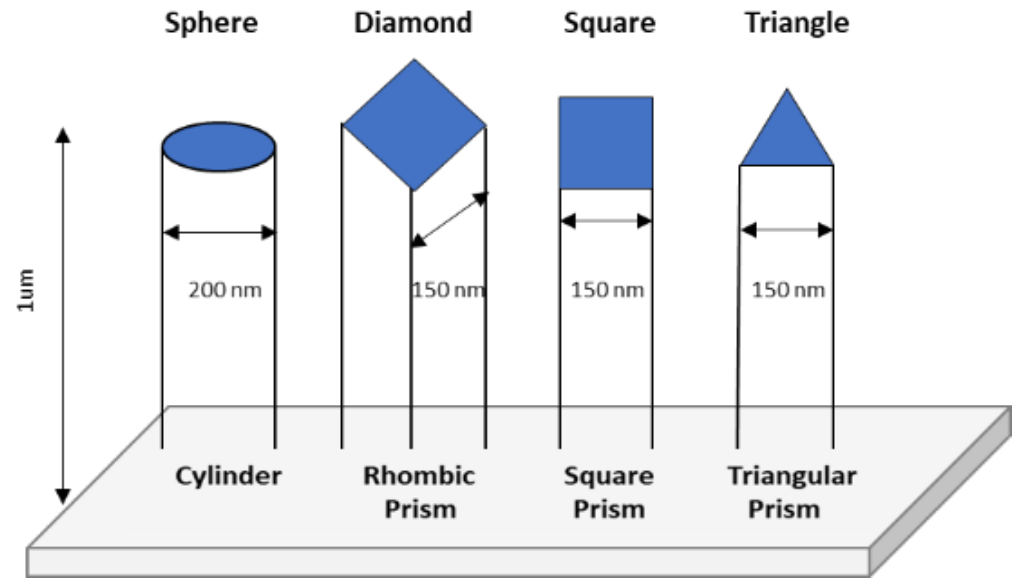
Figure 1. Different geometries used in E-beam pattern for nanoarrays. Figure 1. Di ff erent geometries used in E-beam pattern for